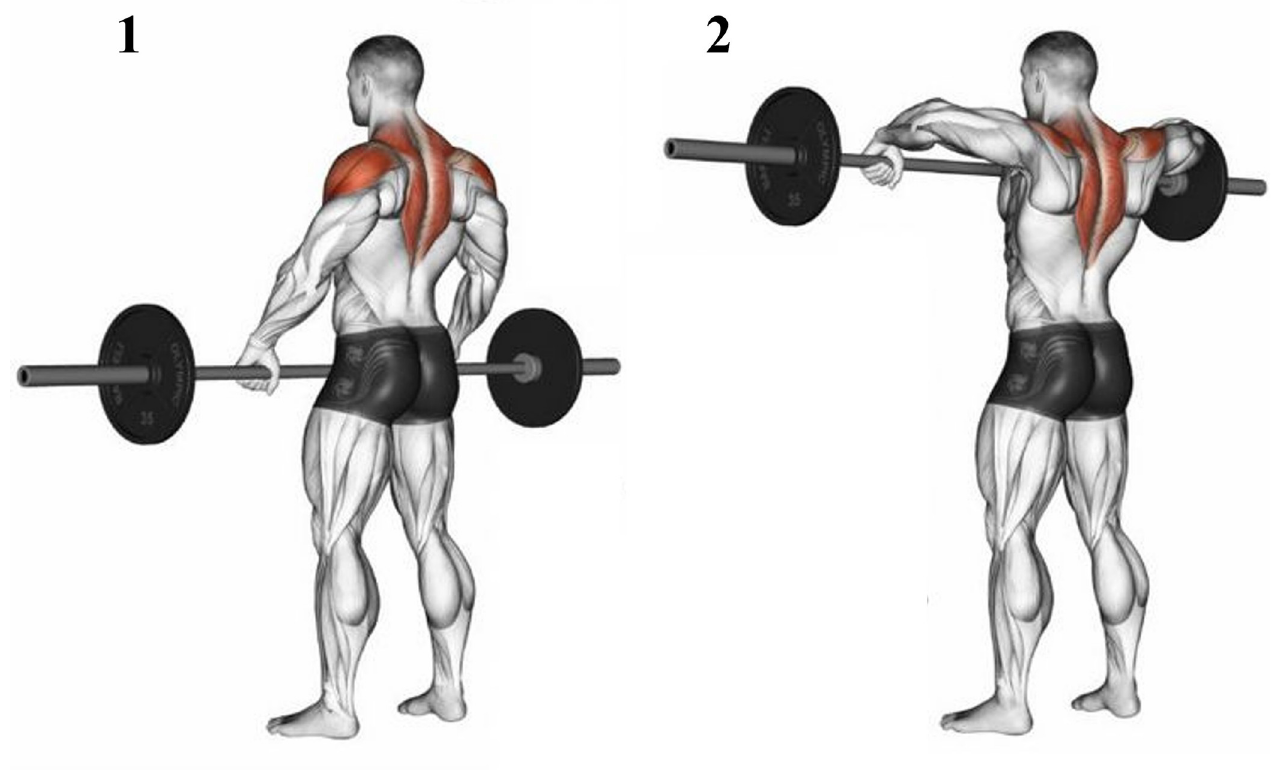
Fig 2. Illustration of endurance static test performed before (ESTpre) and after (ESTpost) the driving session.